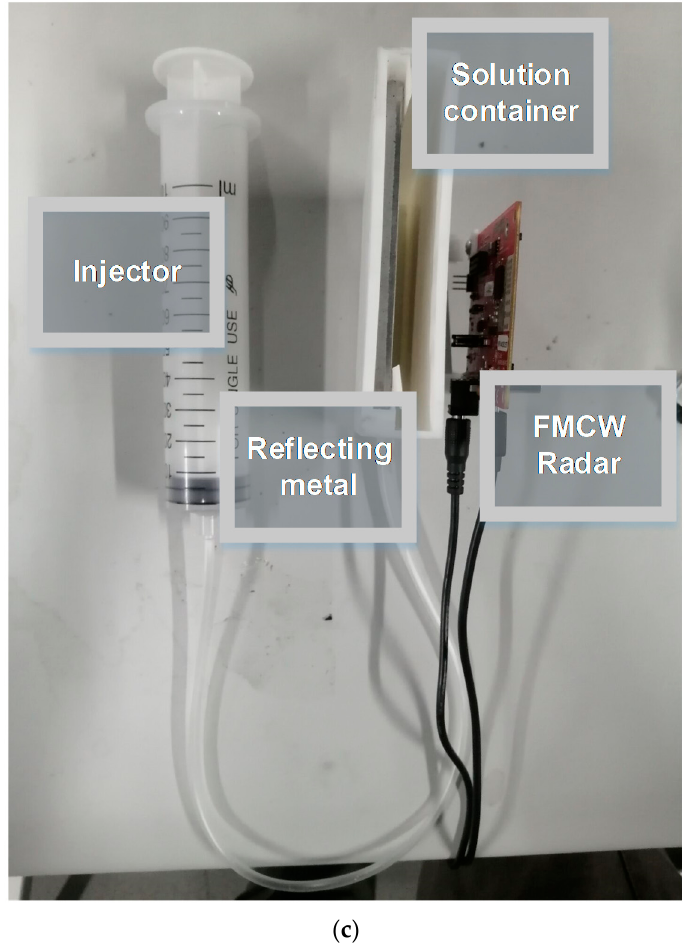
Figure 1. FMCW radar system: ( a ) specific data transfer flow chart; ( b ) the experiment device fixed by 3D printing equipment and covered by microwave absorbing sponge; ( c ) the device equipped with an injector.